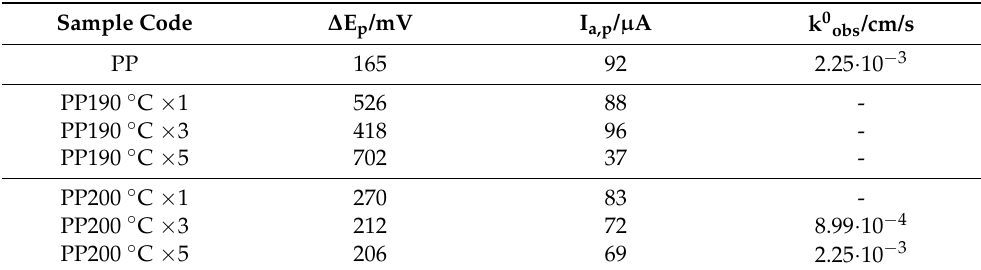
Table 5. Values of ∆ E and I a for CV scans at 100 mV/s after multiple reprocessing of PP. Sample